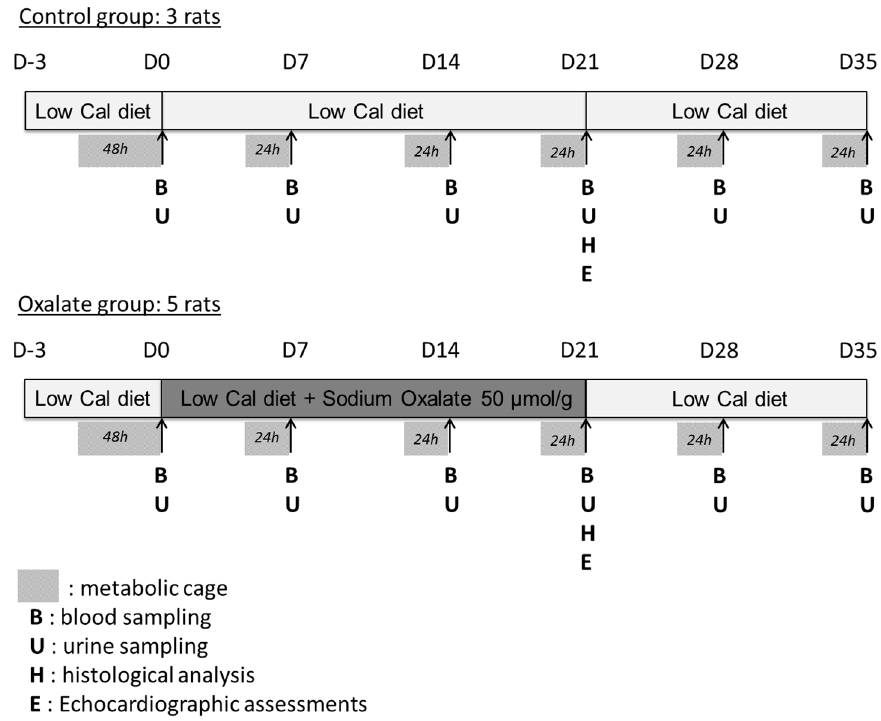
Figure 6. Experimental design of the 5-week regimen for both control and oxalate